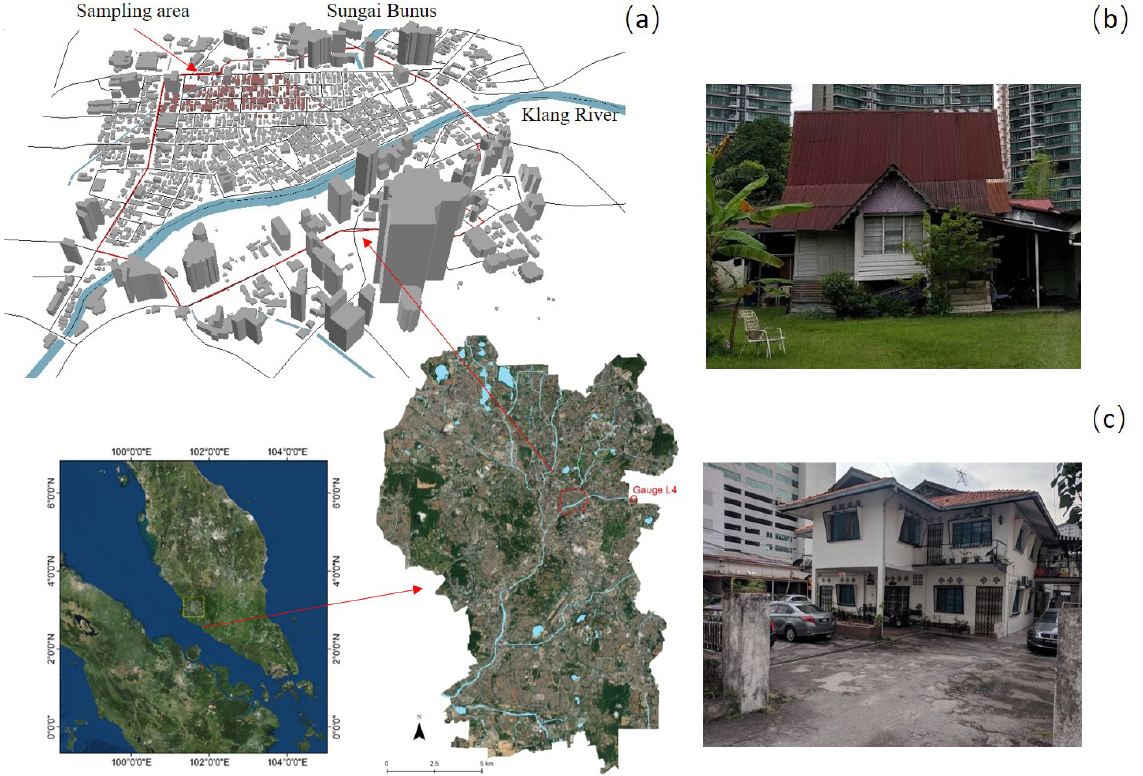
Figure 2. (a) Location of Kampung Baru in the centre of Kuala Lumpur (ESRI ArcGIS ® base map); (b) traditional vernacular house; (c) modern vernacular